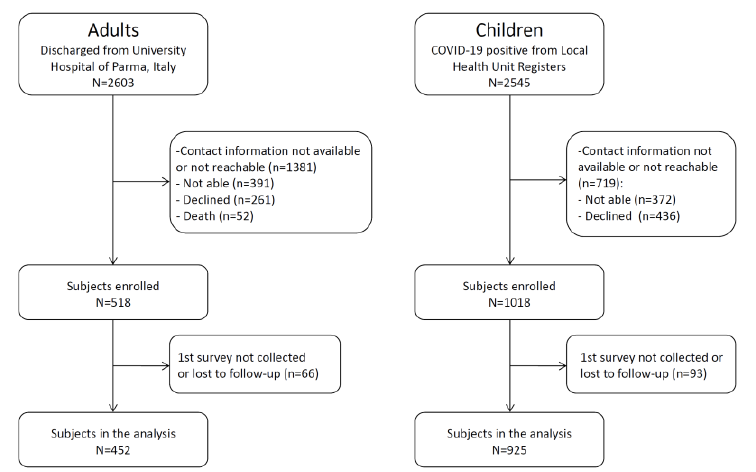
Figure 1. Flow-chart diagram of the cohorts.